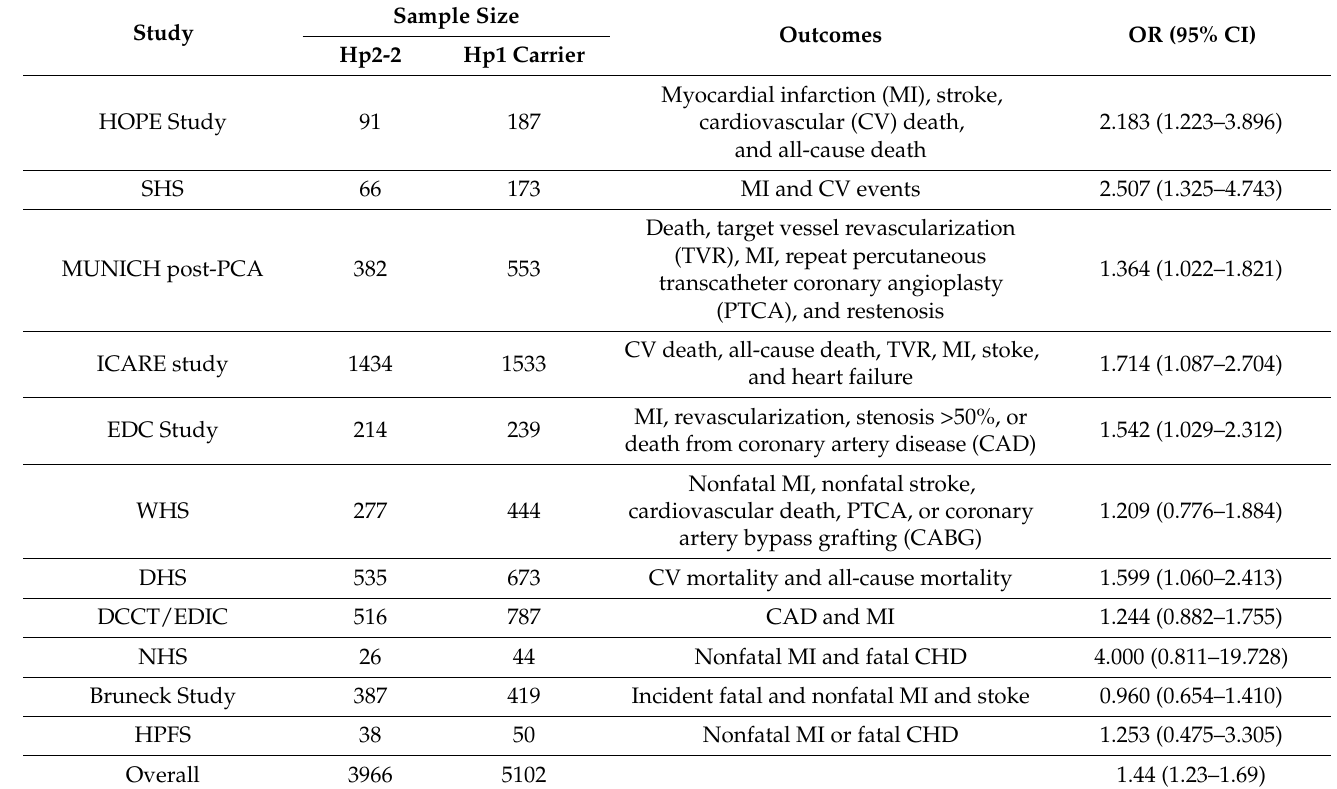
Table 1. Studies assessing incident cardiovascular disease in relation to the haptoglobin genotype. OR is the ratio of disease for Hp 2-2 carriers compared to Hp 1 carriers [13]. HOPE; Heart Outcome Prevention Evaluation, SHS, Strong Heart Study, ICARE, Israel Cardiovascular Vitamin E, EDC, Epidemiology of Diabetes Complications, WHS, Women’s Health Study, Diabetes Heart Study (DHS), DCCT/EDIC, Diabetes Control and Complications Trial/Epidemiology of Diabetes Interventions and Complications, NHS, Nurses’ Health Study, HPFS, Health Professionals Follow-Up